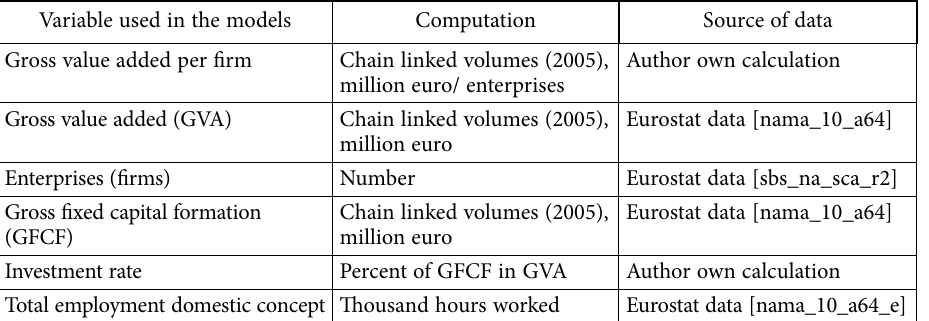
Table 1. Model variables (source: authors’ elaboration) Variable used in the